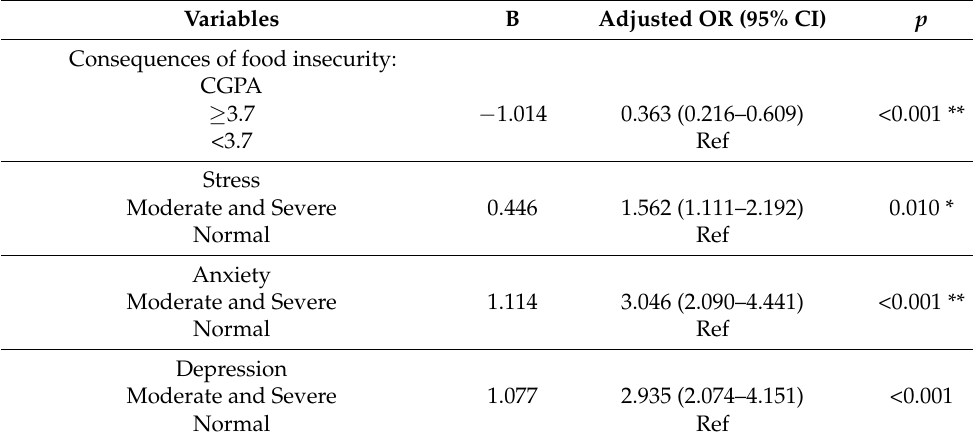
Table 4. Food security status affect psychosocial status and academic